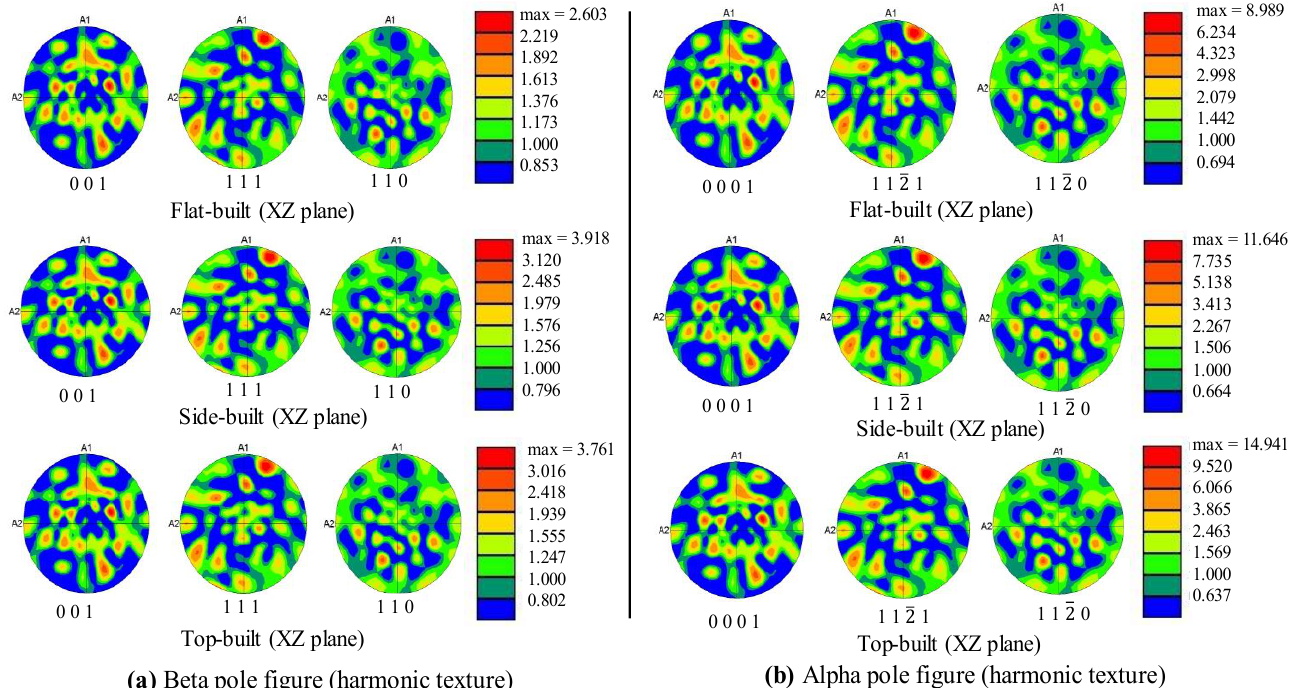
Figure 11. The harmonic texture of the three samples on the XZ plane, showing maximum texture intensity: ( a ) beta pole figure and ( b ) alpha pole figure.